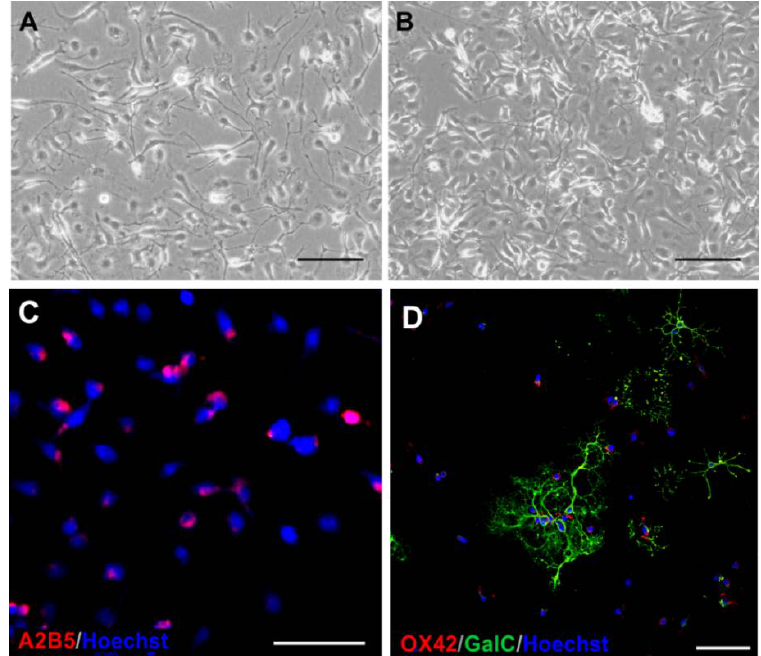
Figure 8. Coculture of rat neonatal oligodendrocytes and microglia. ( A ) Live imaging of control coculture; ( B ) Live imaging of coculture subjected to OGD procedure; ( C ) Immunostaining of cocultured cells with A2B5 antibody (red) allowing to distinguish neural cells, represented by oligodendrocytes. Microglia of mesenchymal origin remains unstained. ( D ) Differentiating, GalC-positive oligodendrocytes (green) cocultured with microglia, immunolabelled with OX42 marker (red). Cell nuclei are stained with Hoechst dye (blue). The scale bar is an equivalent to 50 μm.